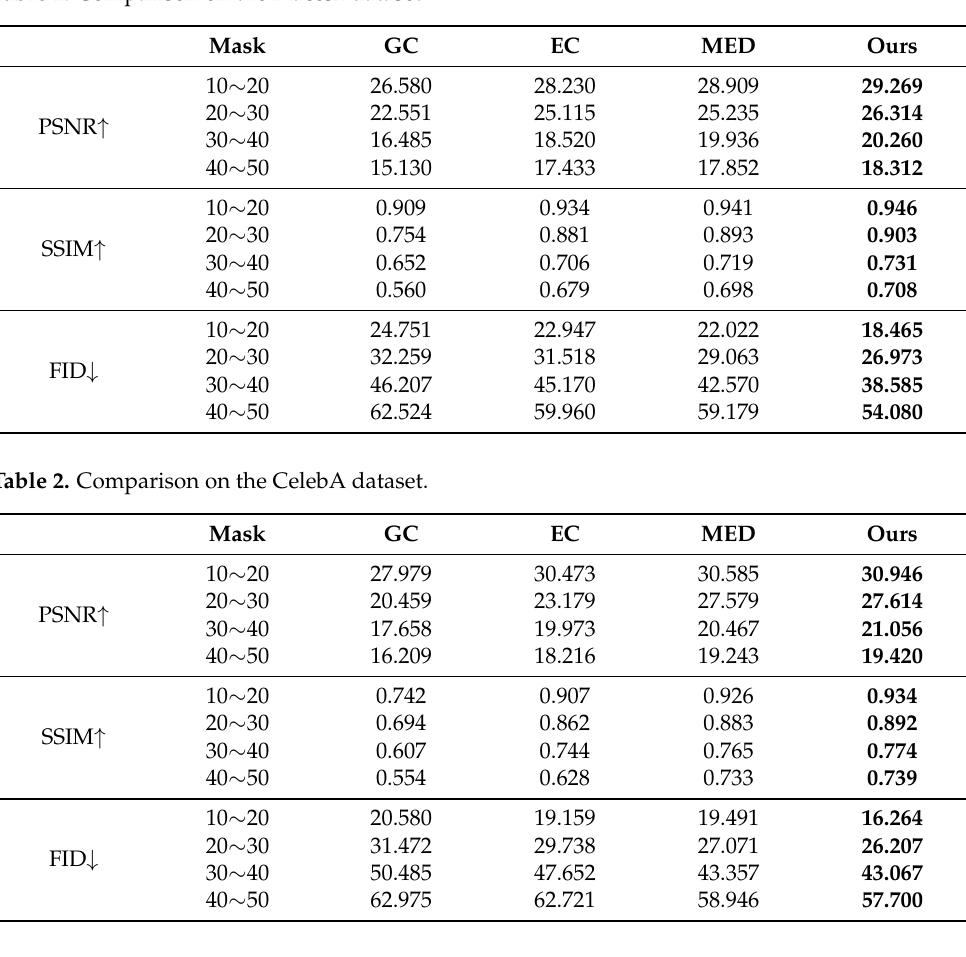
Table 1. Comparison on the Places2 dataset.